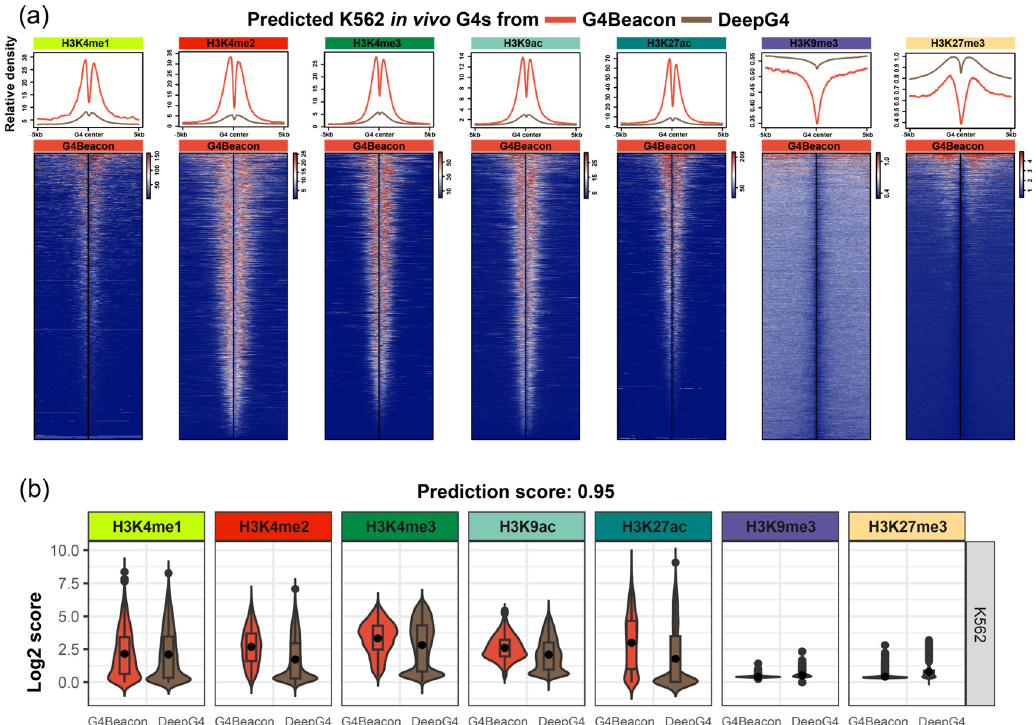
Figure 5. Results of the histone modification state analysis on G4Beacon and DeepG4 prediction results. ( a ) The line charts and heatmaps of histone modification states around K562 active G4s derived from G4Beacon and DeepG4, with the probability threshold of 0.5. ( b ) The boxplots of histone modification state scores of K562 active G4s derived from G4Beacon and DeepG4, with the probability threshold of 0.95.